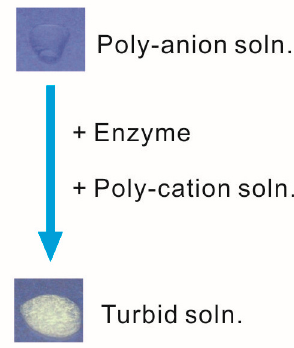
Figure 5. Preparation method of polyion complex membrane. A poly ‐ anion solution, anionic polyelectrolyte solution, is placed on the substrate (in this case, a glass plate was used). Enzyme (and chemicals) solution and poly ‐ cation solution are successively placed on it. Immediately after placing the third solution, the mixed solution becomes turbid. After drying, the enzyme ‐ immobilized polyion complex membrane is obtained [10].